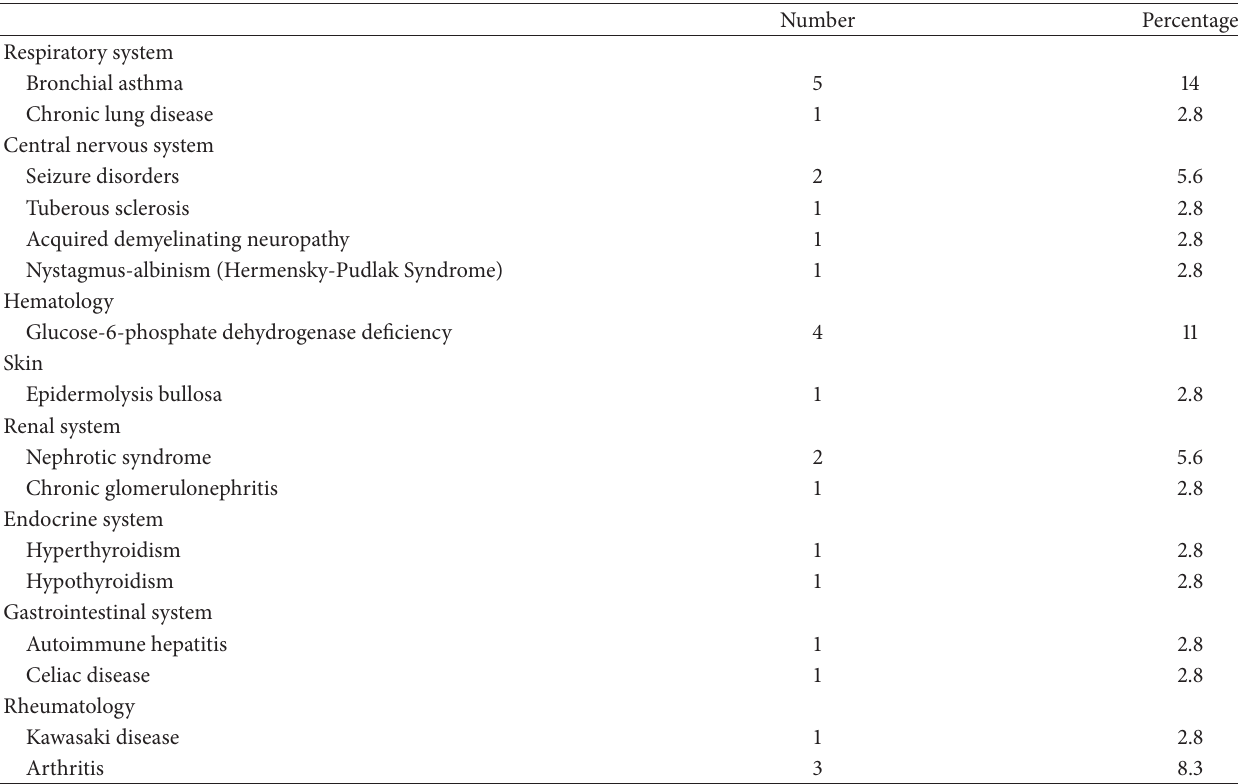
Table 2: Associated comorbidity in 36 patients with Crohn’s disease.